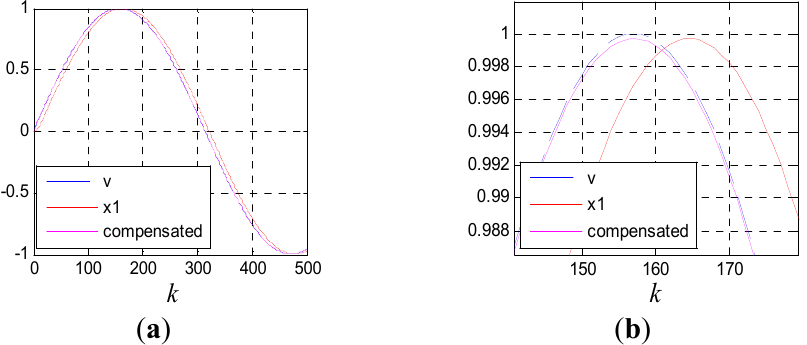
Figure 14. ( a ) Compensation effect for x